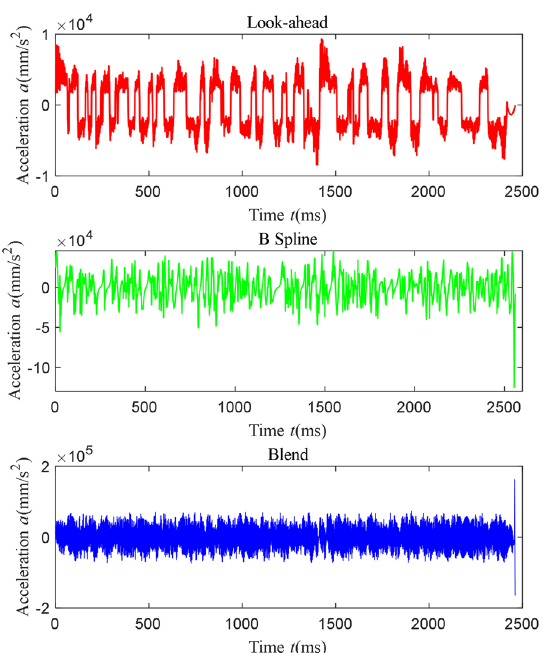
Figure 13 Comparison of acceleration values obtained using the three methods